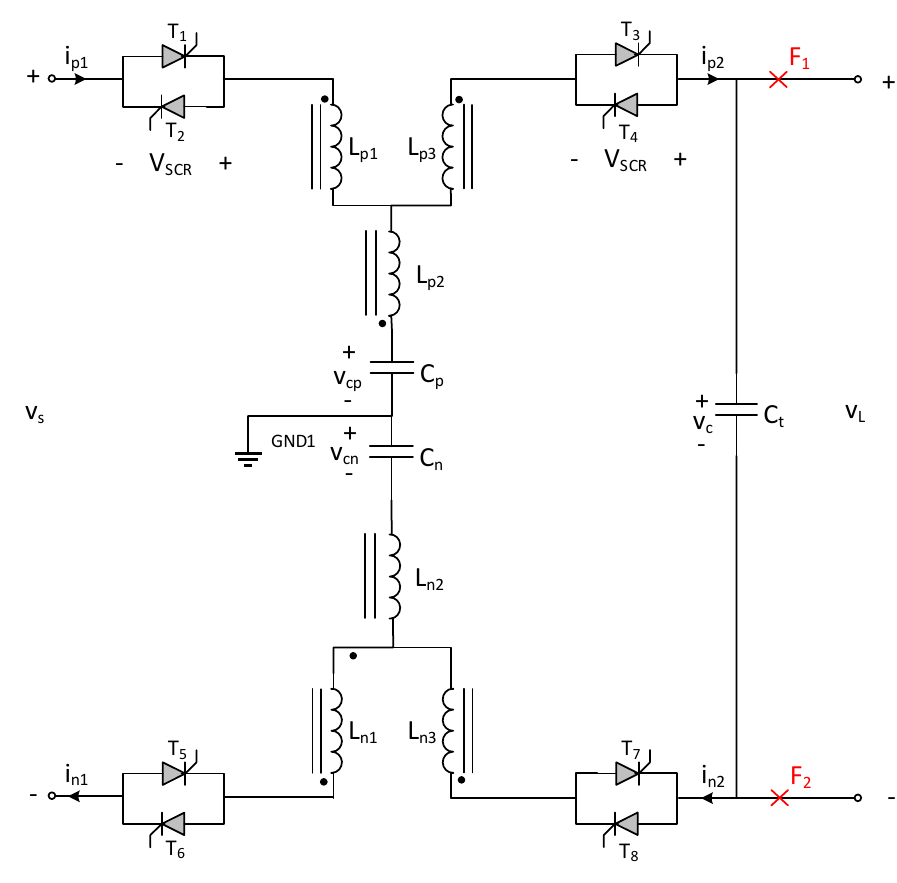
Figure 8. Two levels bi-directional Y-source circuit breaker.